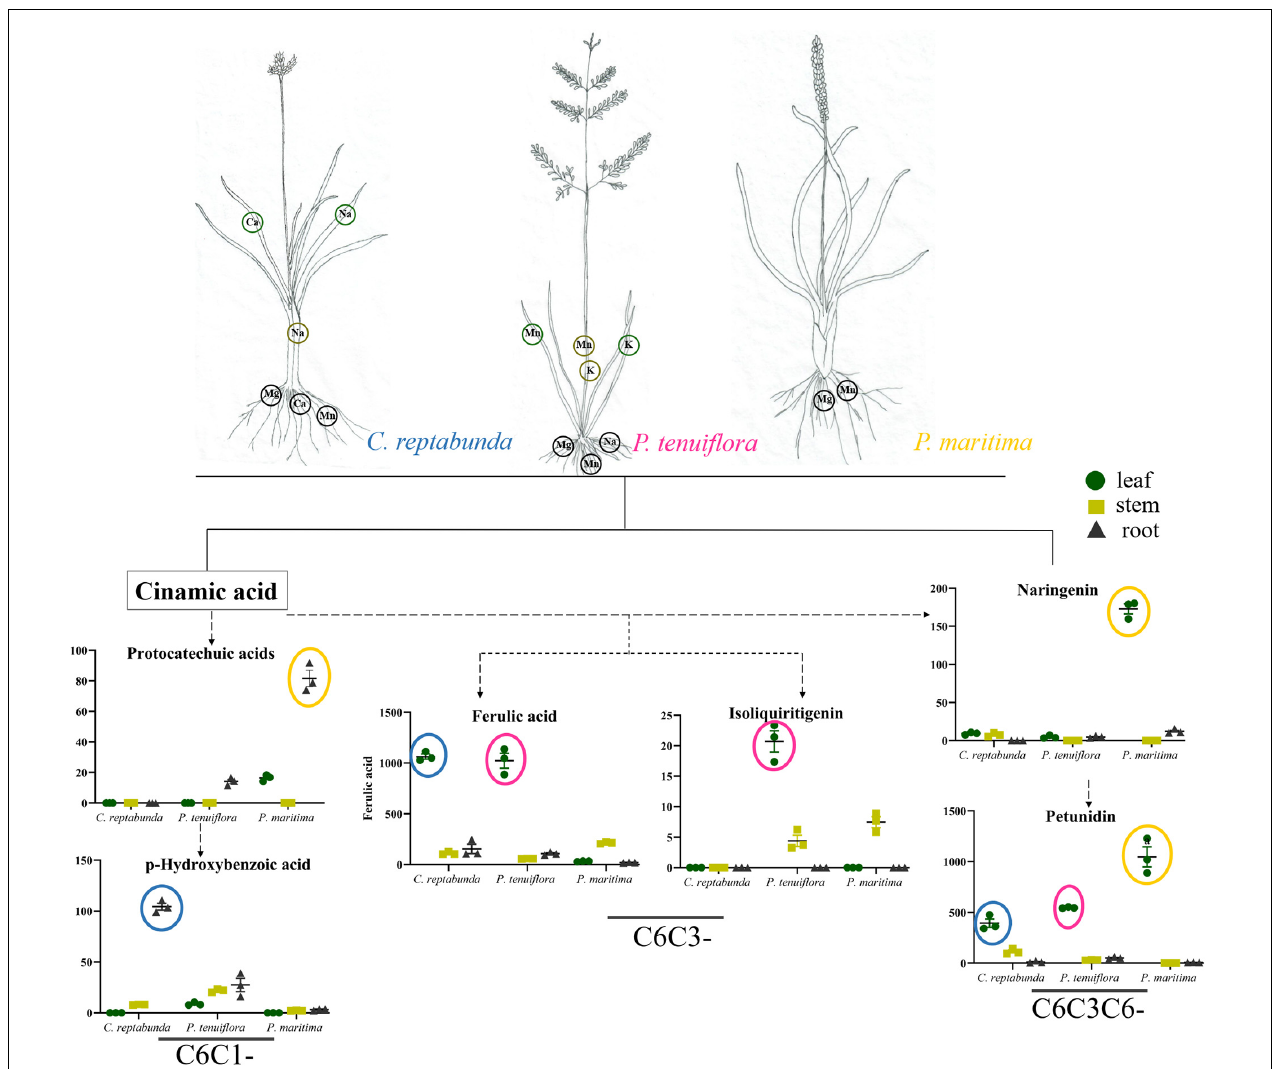
FIGURE 7 | Visualization of pathway maps of significantly different elements and phenolic metabolites in P. tenuiflora community. Blue circle, highly expressed in C. reptabunda , pink circle, highly expressed in P. tenuiflora , orange circle, highly expressed in P. maritime . The green circle, yellow circle, and black circle represent leaf, stem and root,